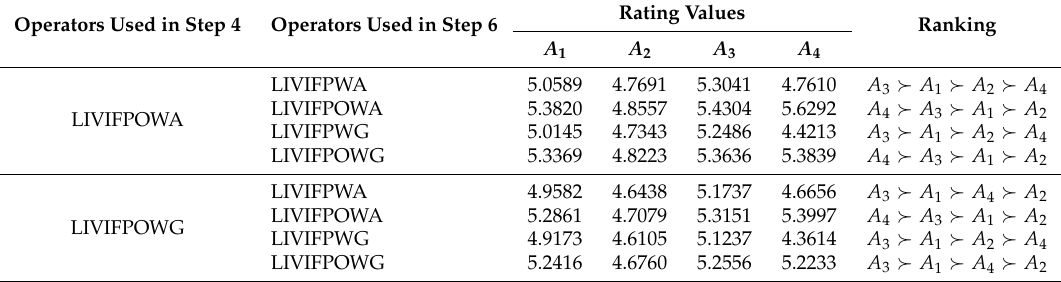
Table 6. The effect of the operators on the alternatives and ranking order. LIVIFPOWA, linguistic interval-valued intuitionistic fuzzy prioritized ordered weighted averaging; LIVIFPWA, LIVIF prioritized weighted averaging; LIVIFPWG, LIVIF prioritized weighted geometric; LIVIFPOWG, LIVIF prioritized ordered weighted geometric.